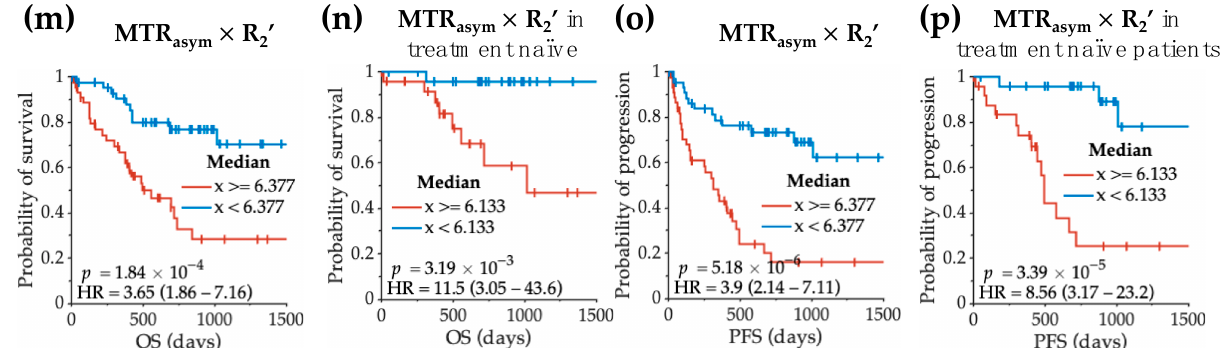
Figure 7. Log-rank analyses of residual overall survival (OS) and residual progression-free survival (PFS) with clinical variables ( a – d ) and MRI features ( e – p ). The log-rank tests were performed with the entire patient cohort if not otherwise specified. The OS refers to the residual OS from the patient scan date to the date of death. The PFS refers to the residual PFS from patient scan date to the date of disease recurrence.